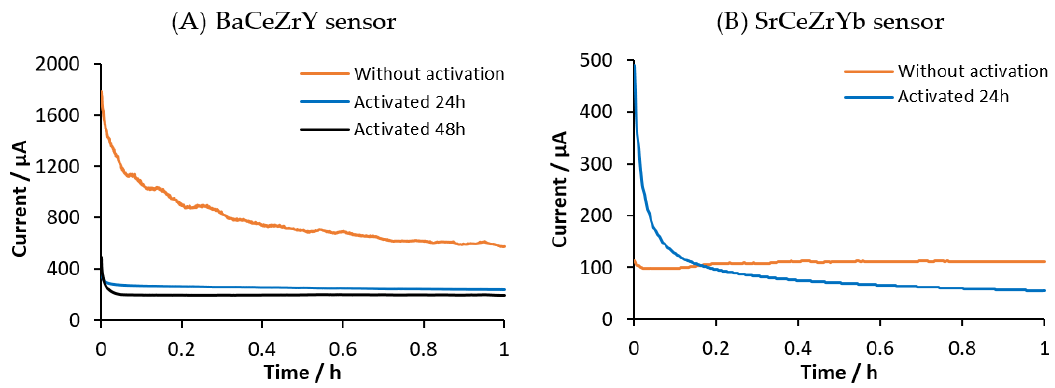
Figure 4. Comparison between the amperometric blank response without activation and activated ( A ) for 24 h and 48 h with the BaCeZrY sensor and ( B ) for 24 h with the SrCeZrYb sensor.